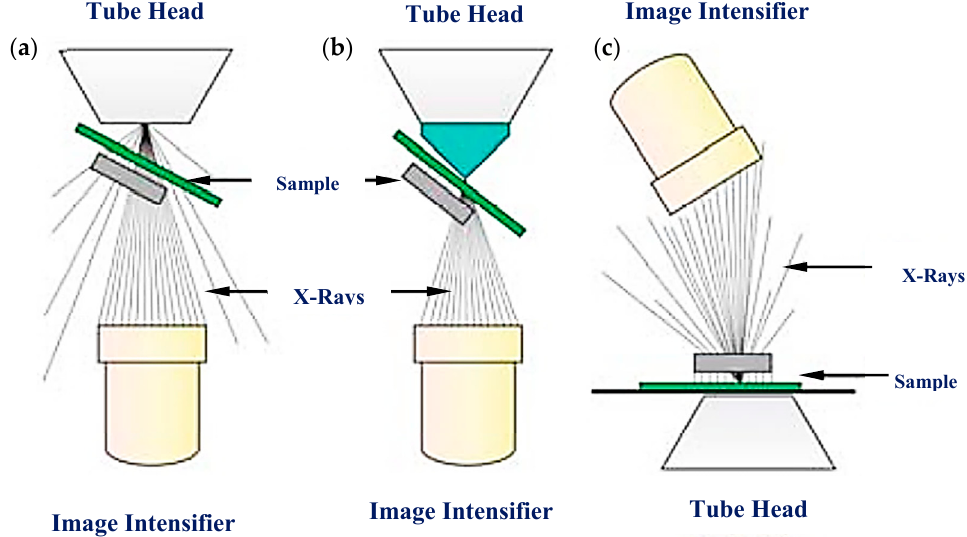
Figure 4. Different configurations of the isocentric motion technology X-ray inspection method to achieve oblique viewing (3D): ( a ) conventional, ( b ) advanced, and ( c ) close-to-focus [32].